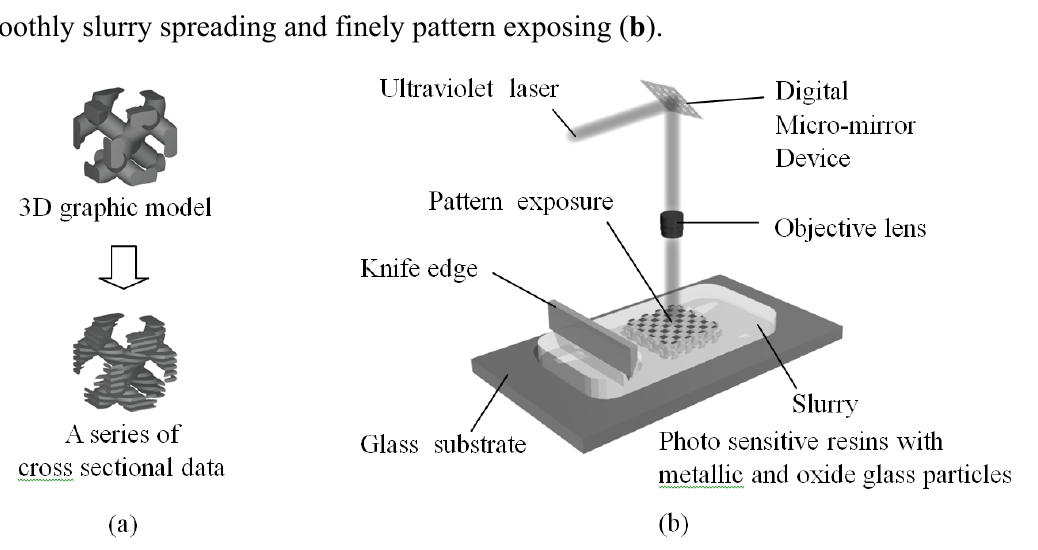
Figure 2. Schematic illustrations of a stereolithographic method. A three dimensional model was sliced into two dimensional cross sections by computer graphic technique ( a ).